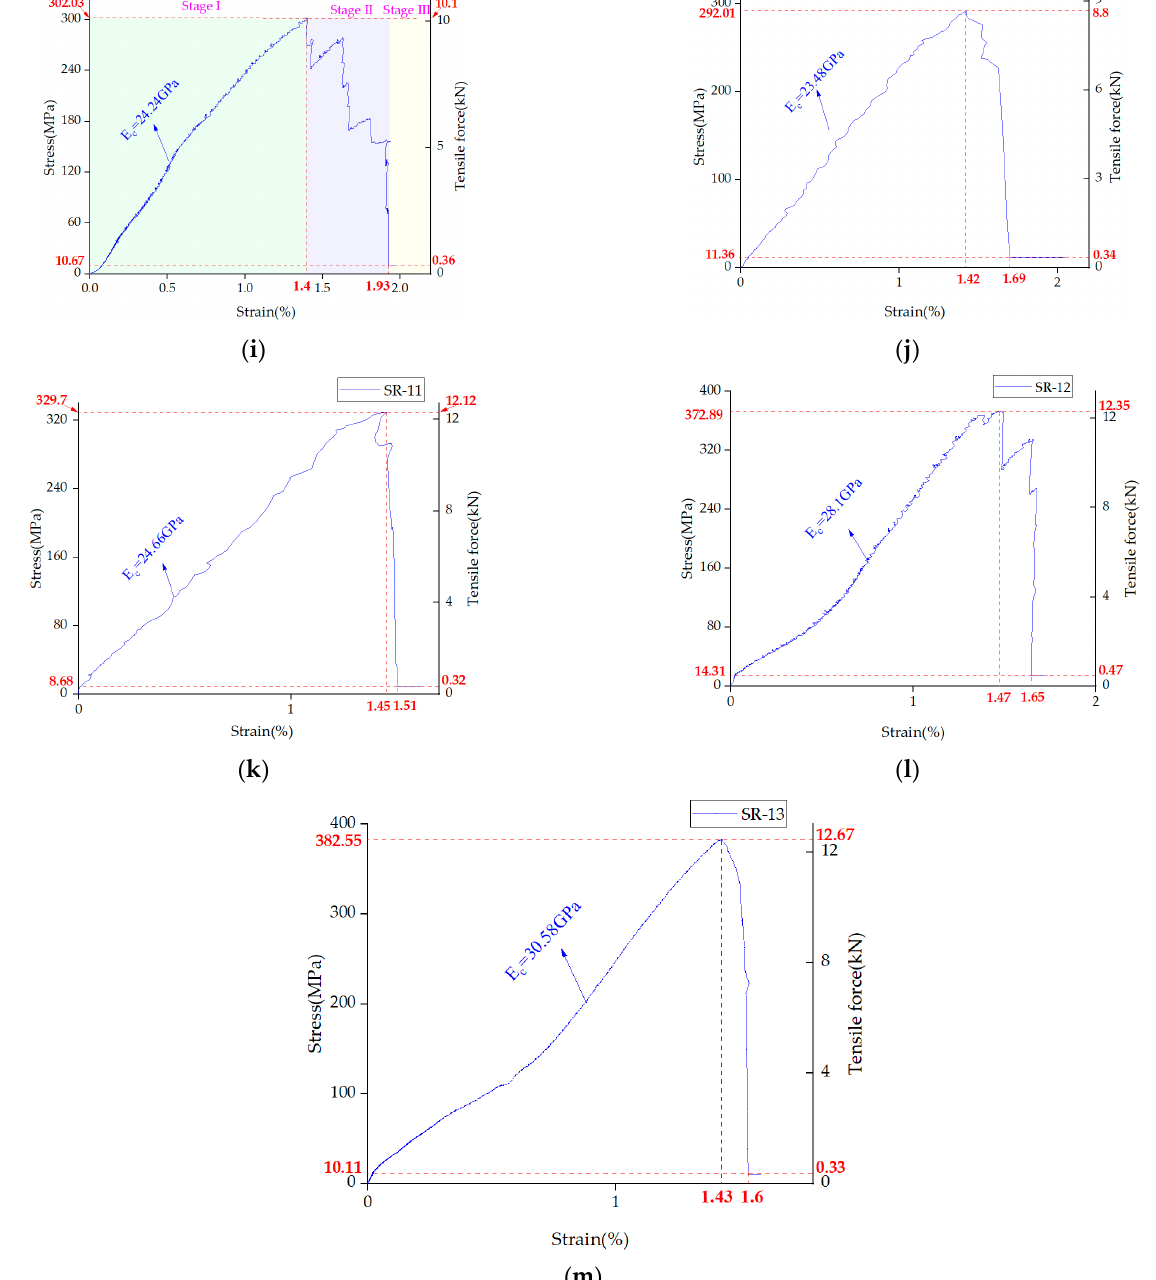
Figure 8. Tensile stress–strain and tensile curve of steel–plastic compound geogrid-reinforced belt: ( a – m ) SR-1 to SR-13.